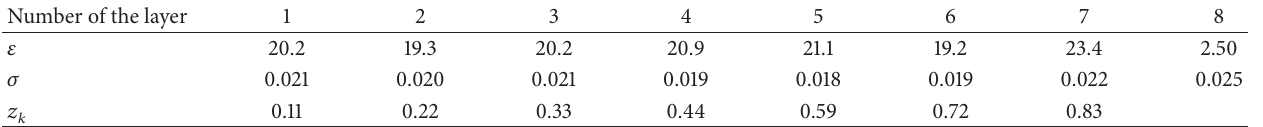
Table 5: Model of the medium